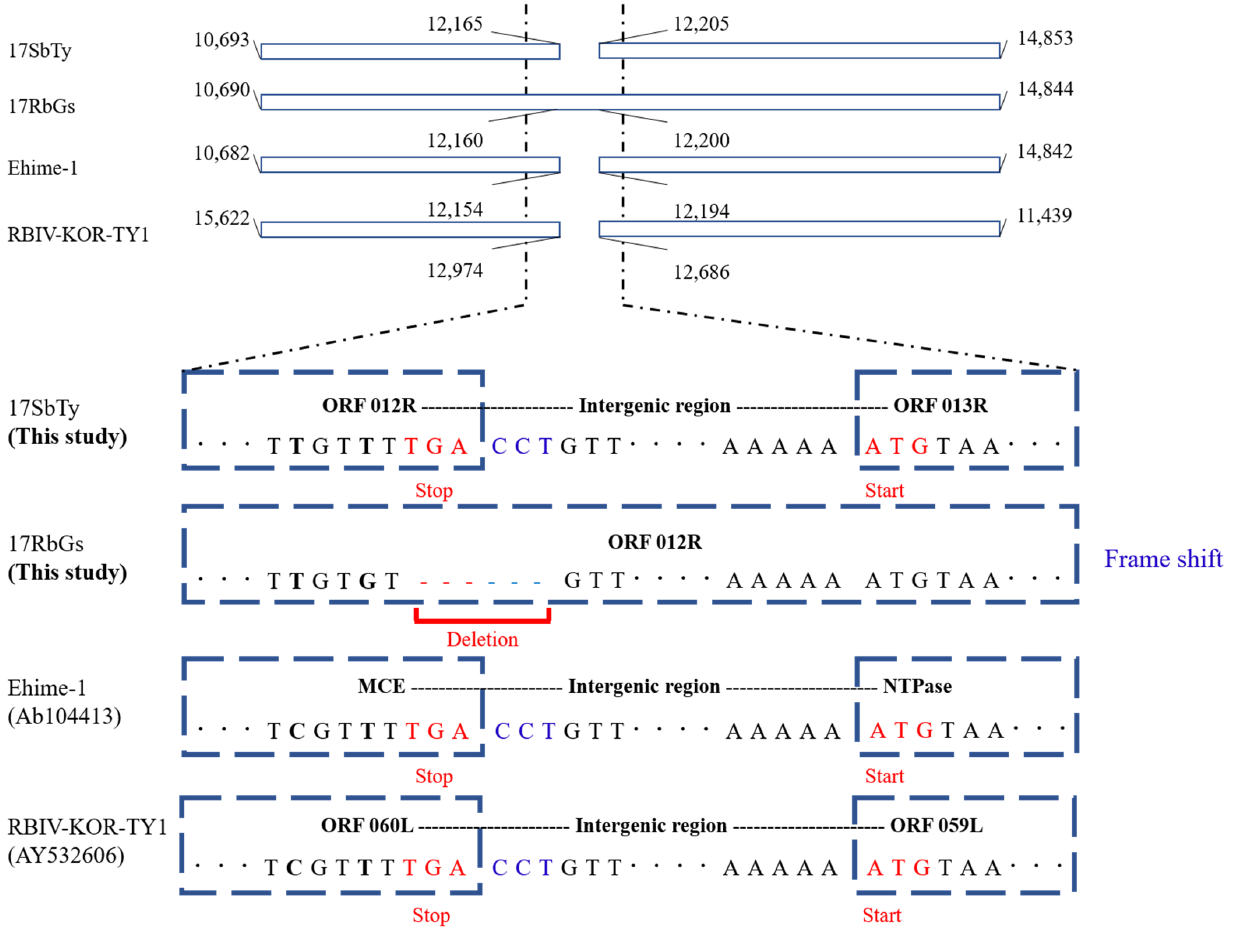
Figure 4. Schematic representation of a deletion of the termination codon in ORF 012R of 17RbGs causing a frameshift mutation. The aligned sequences are genomes of 17SbTy, 17RbGs, and two representative RSIVs (Ehime-1 [RSIV subtype I] and RBIV-KOR-TY1 [RSIV subtype II]). The nucleotide sequences surrounded by blue dashed lines are coding regions. The termination and start codons are shown in red, and the deleted sequences in the intergenic region are highlighted in blue.